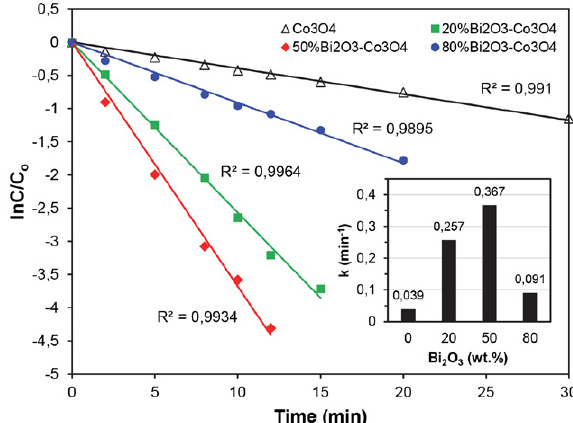
Fig. 7. First‐order kinetic fitting of the AO7 degradation curves. Re- action conditions: [AO7] o = 50 mg/L; [PMS]/[AO7] = 6; [Catalyst] = 0.1 g/L; initial pH = 3.04; T = 293